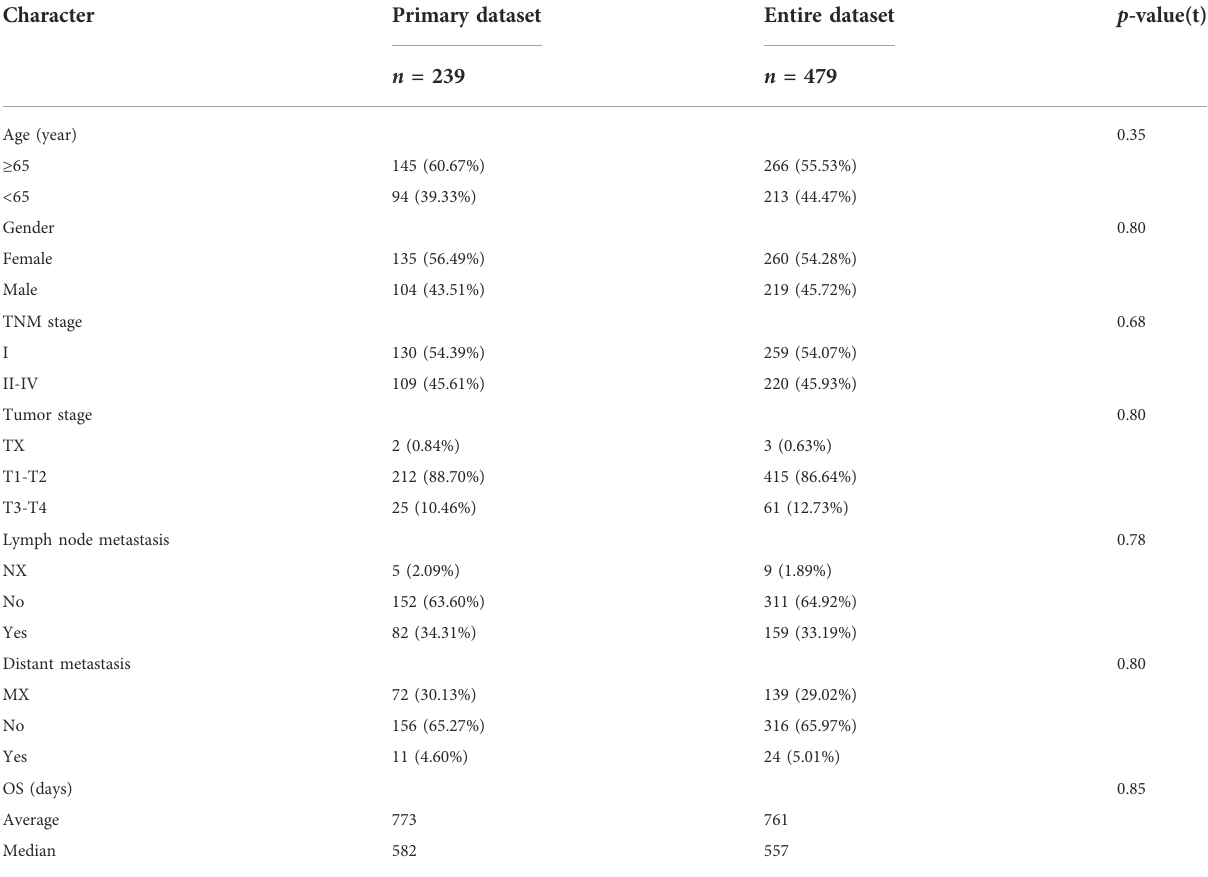
TABLE 1 Baseline clinical characteristics and OS between the “ entire dataset ” and the “ primary dataset ” .